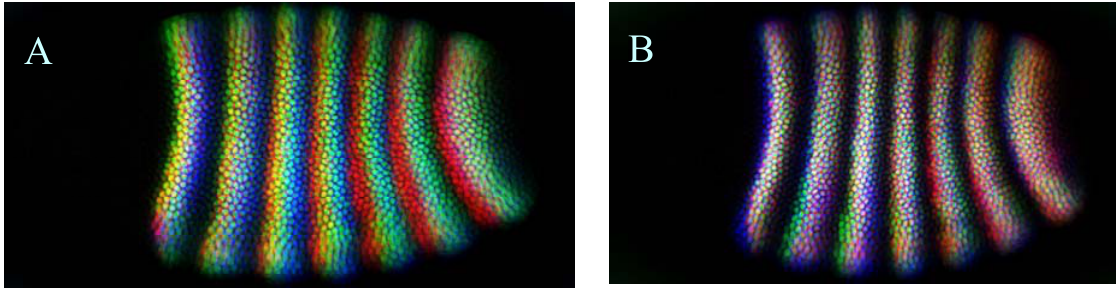
Figure 8: Three expression patterns of even-skipped gene before registration (A) and after registration